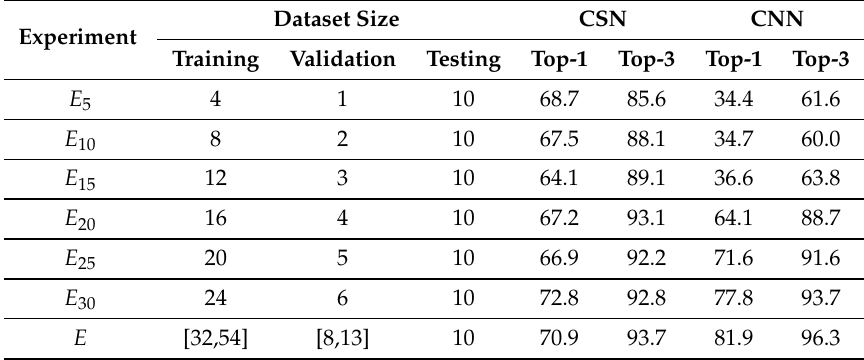
Table 2. Scenario 1: accuracy achieved for different dataset sizes.